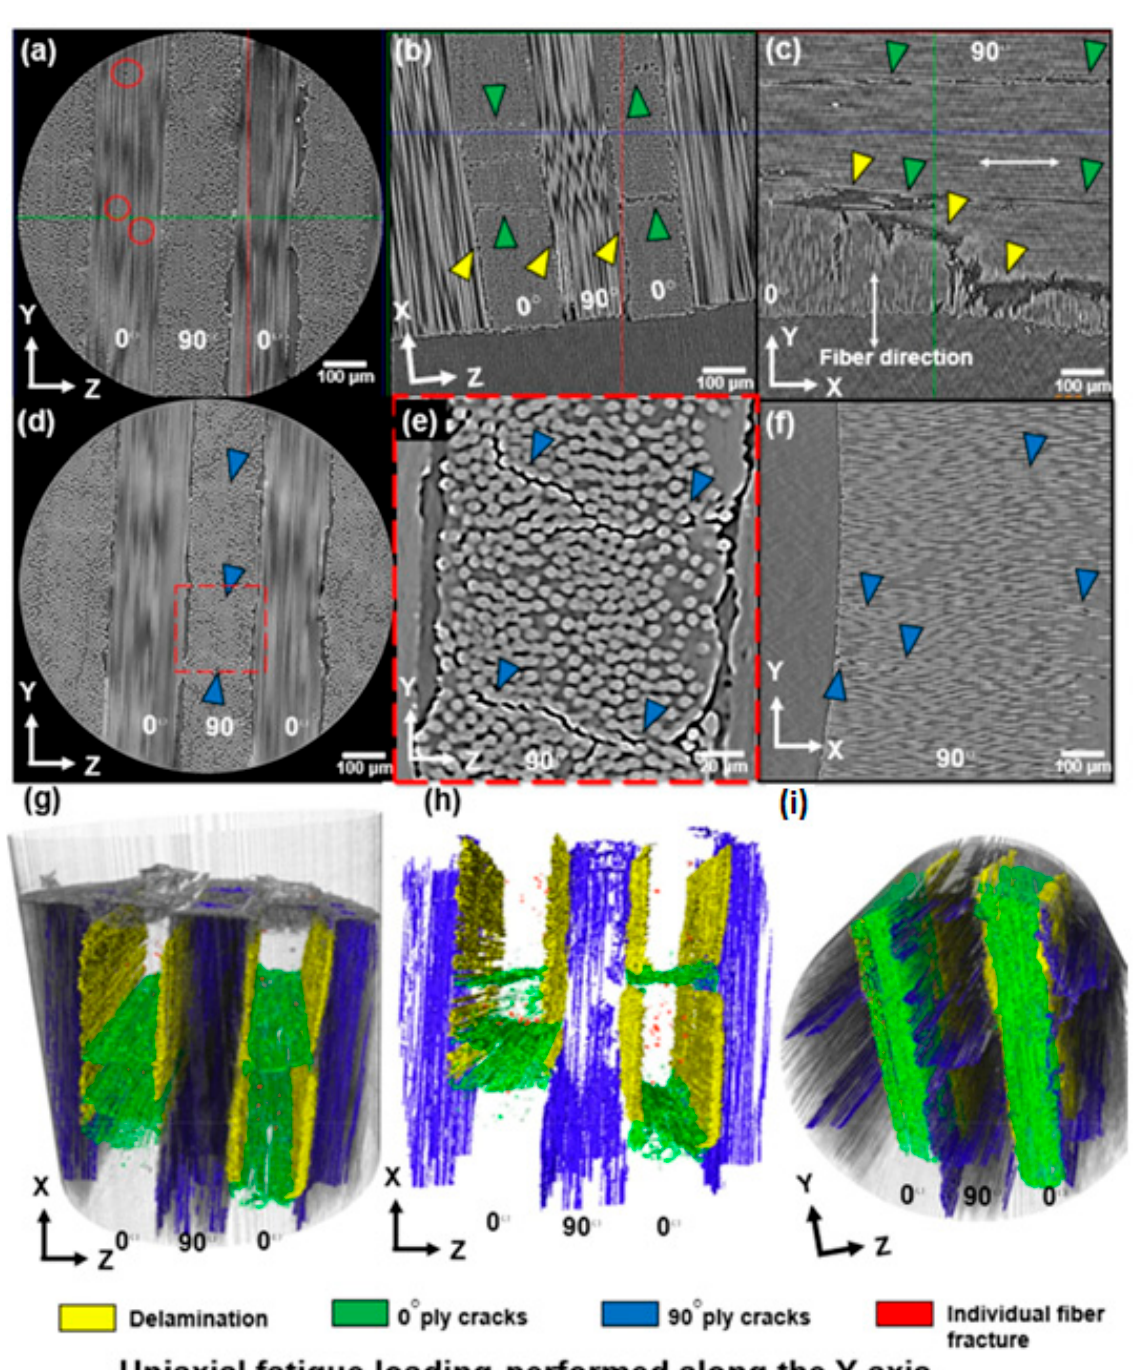
Figure 37. The 3D imaging and segmentation of the milled CFRP sample after fatigue loading process ( a ) fiber breakage in ZY plane, ( b ) combination of 0° ply cracks and delamination in ZX plane, ( c ) delamination at the interface between two orthogonal adjacent plies in XY plane, ( d ) ZY plane showing another location on 90° ply with interfiber cracking magnified in ( e ), ( f ) 90° ply cracking running horizontally in XY plane, ( g – i ) segmented volume renderings showing the ZX plane region of interest with minimal fiber damage on cut surface (top) and all the mechanisms in play, adapted with permission from Ref. [121]. Copyright © 2021 Elsevier